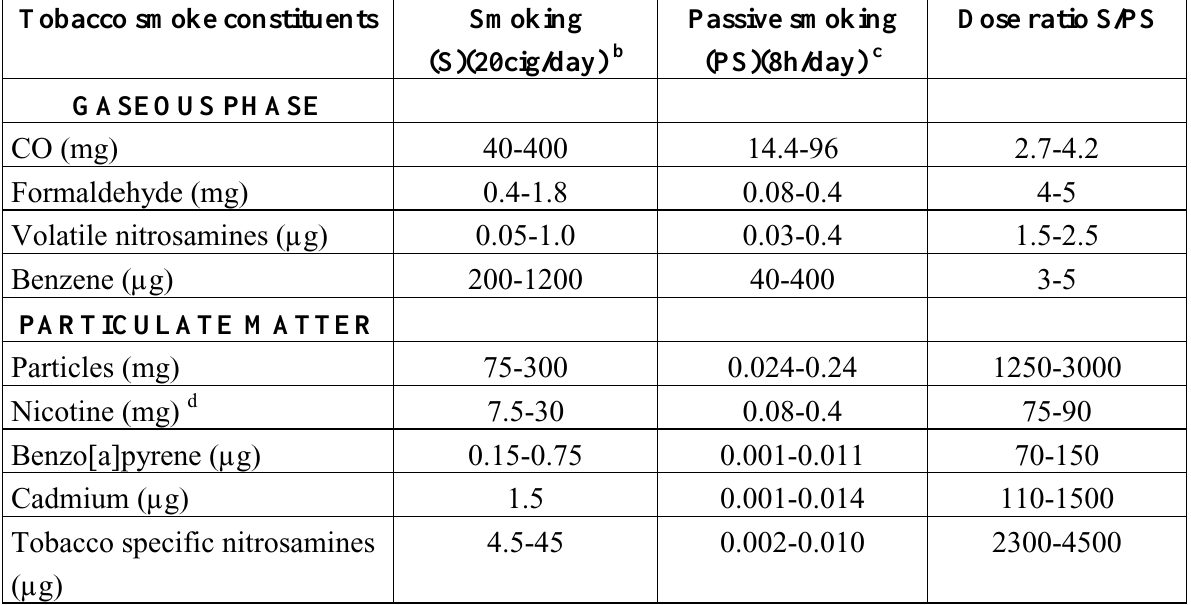
Table 3. Estimated dose ratio between active smoking (20 cig./day) and passive smoking (8 h/day) (Scherer et al.